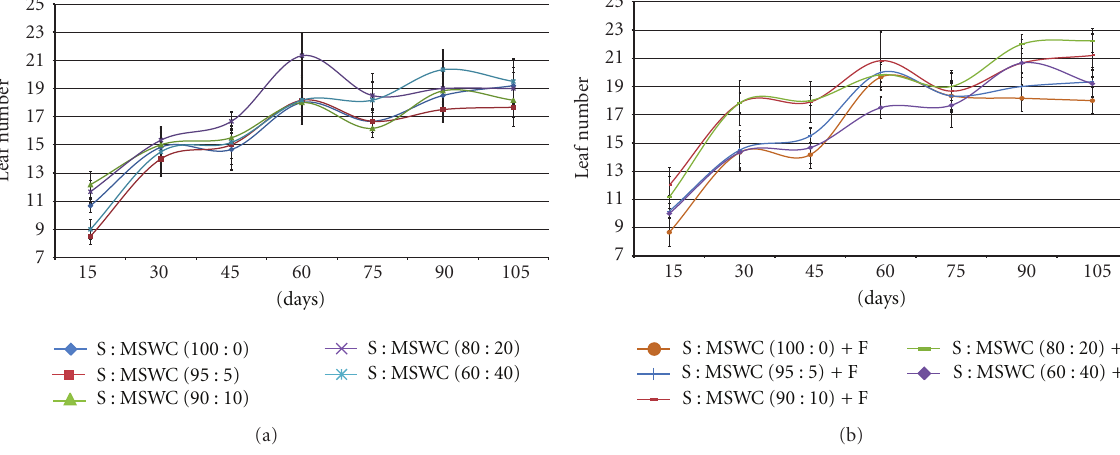
Figure 3: E ff ects of municipal solid waste compost (MSWC) into soil (S) without (a) or with (b) fertigation (F) on leaf number produced in greenhouse pepper crop. Values represent mean ( ± SE) of measurements made on six plants per